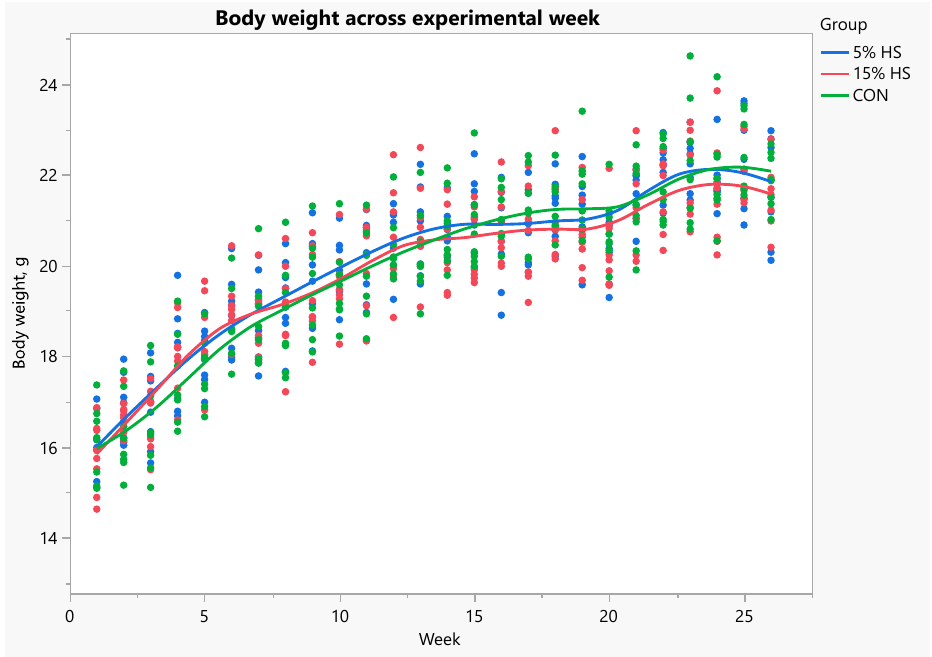
Figure 3. Body weight measured at week’s end across experimental weeks. N = 8 per group. Each dot represents an individual mouse; colors represent the experimental diet group. Mixed models with repeated measures showed no significant differences across groups ( p = 0.19). Effect of week, p < 0.0001.